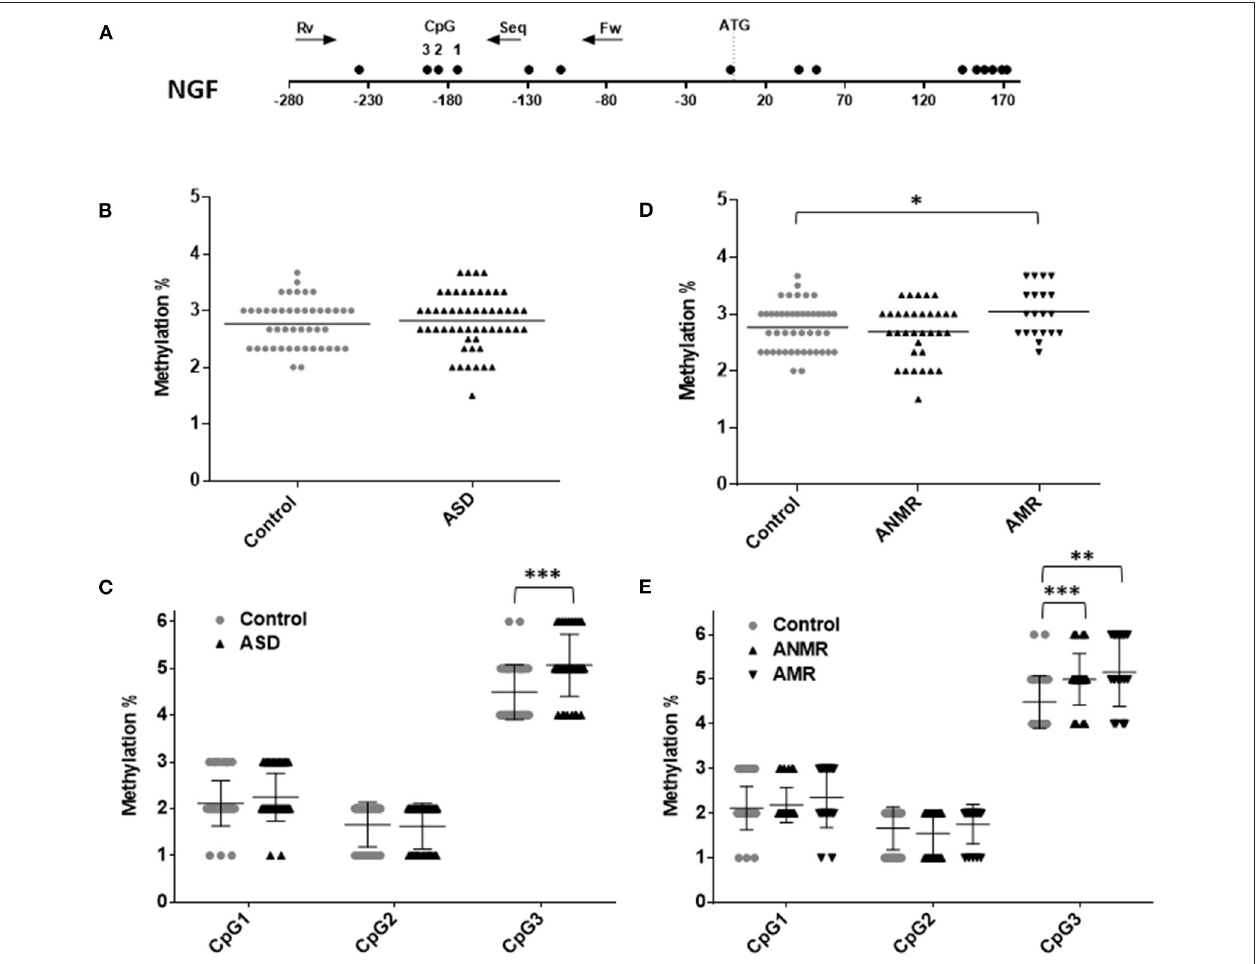
FIGURE 3 | Scatter plot showing comparisons of methylation status of NGF in children with autism spectrum disorders (ASD) compared to controls. (A) Schematic diagram of analyzed gene. Each circle represents a CpG dinucleotide. Position of ATG codon is indicated. Arrows show the location of pyrosequencing primers. (B,C) Methylation levels and differentially methylated sites (CpG 1, 2, and 3) in the NGF gene in ASD group and healthy control group. (D,E) Methylation levels and differentially methylated sites in the NGF gene in ASD group subdivided as follows: ANMR (non-mental regression group), AMR (mental regression group), and a healthy control group. The dark bars represent the mean values of each group. Asterisks indicate statistically significant differences ( * P < 0.05; ** P < 0.01; *** P < 0.001) compared to control